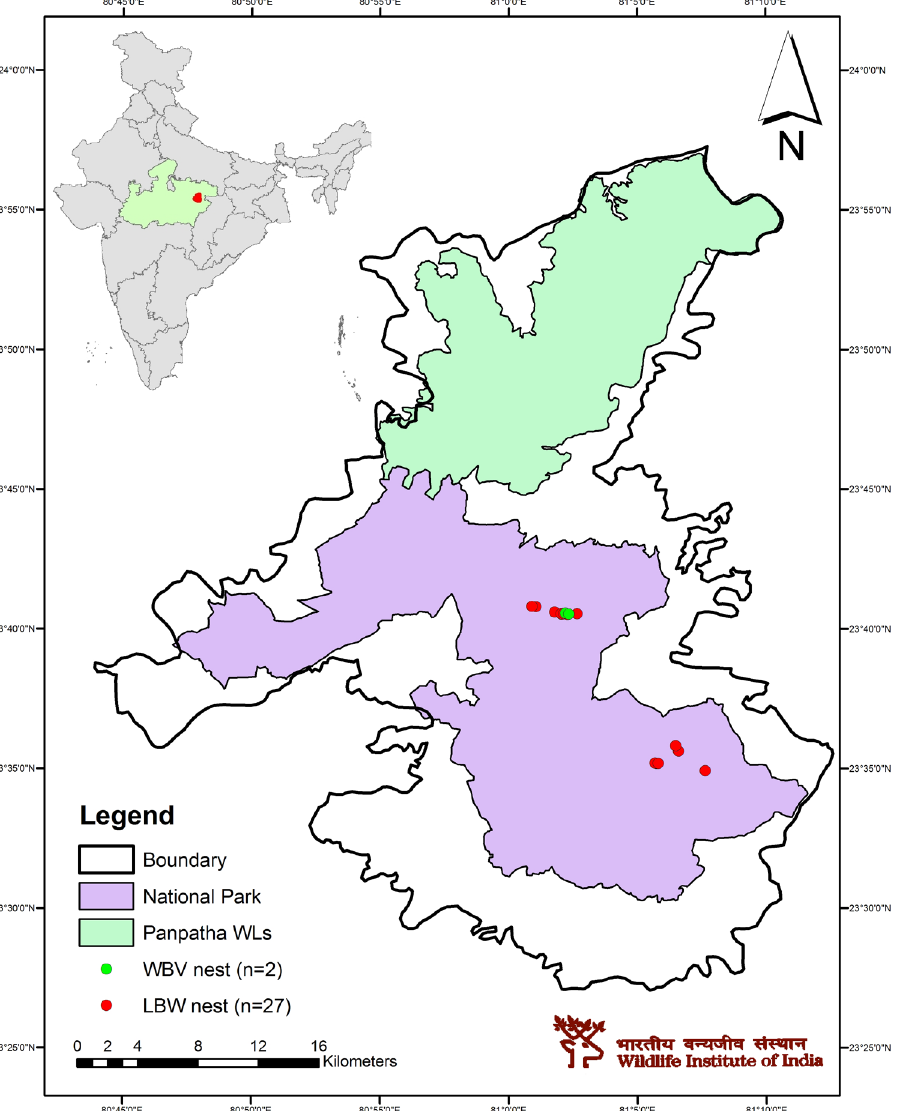
Figure 1. Bandhavgarh Tiger Reserve, showing the location of Long-billed Vulture and White-backed Vulture nest